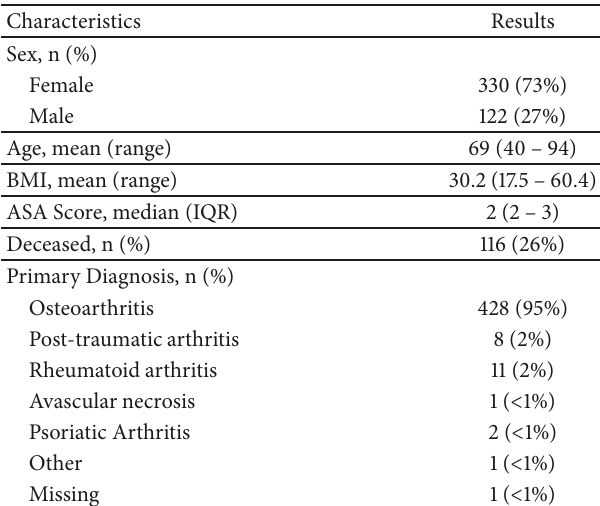
Table 1: Patient